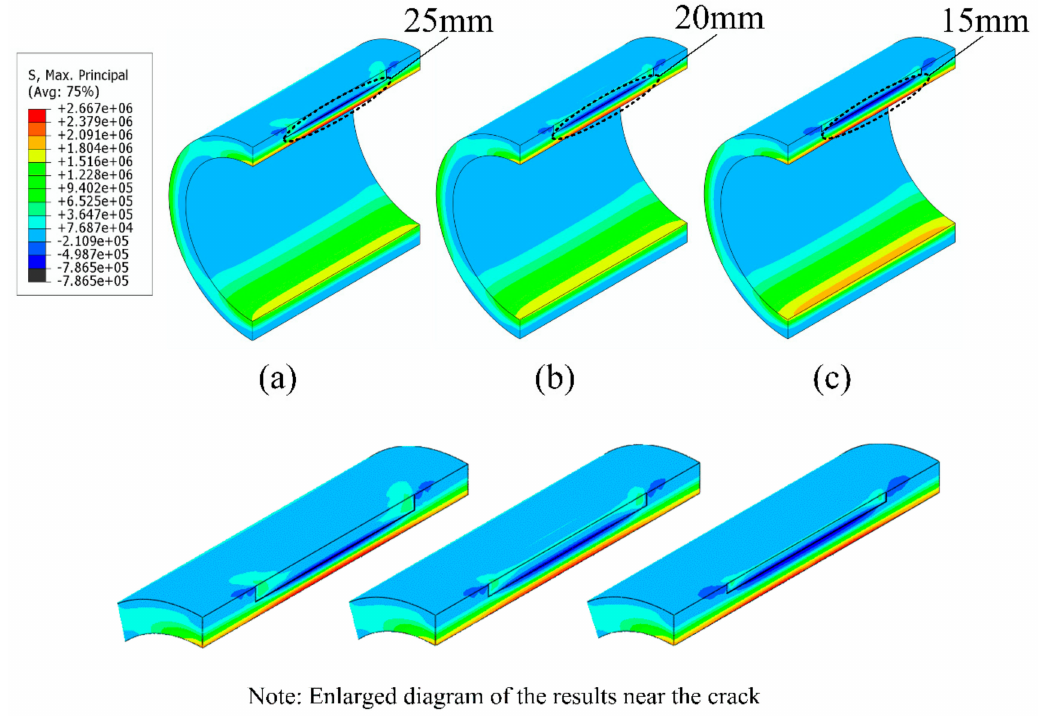
Figure 19. Nephogram of the maximum principal stress of the pipes containing cracks with di ff erent depths ( a ) 25 mm, ( b ) 20 mm, and ( c ) 15